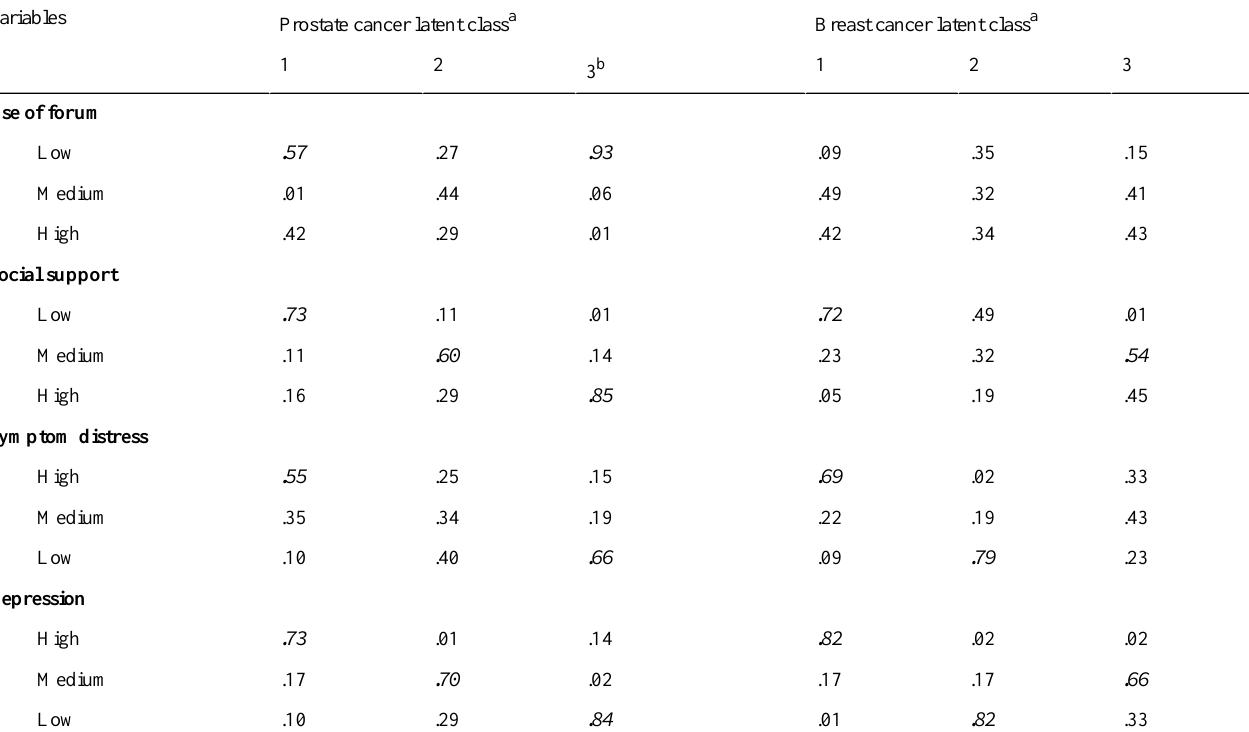
Table 9. Use of the forum component in WebChoice (in minutes). Latent class model, association with levels of social support, symptom distress, and depression. The numbers represent item probabilities. All models were stratified by diagnosis and adjusted for age at